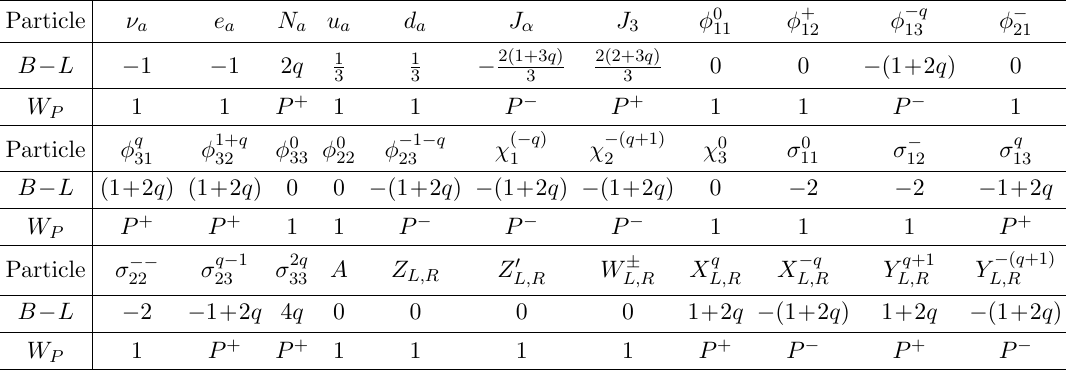
Table 1 . The B (cid:0) L number and W -parity of the model particles, with P (cid:6) (cid:17) ( (cid:0) 1) (cid:6) (6 q +1) . have di(cid:11)erent B (cid:0) L numbers than those of the standard model. Recall that W -parity is only trivial for q = (2 m (cid:0) 1) = 6 = (cid:6) 1 = 6 ; (cid:6) 1 = 2 ; (cid:6) 5 = 6 ; (cid:6) 7 = 6 ; (cid:1) (cid:1) (cid:1) , values not studied in